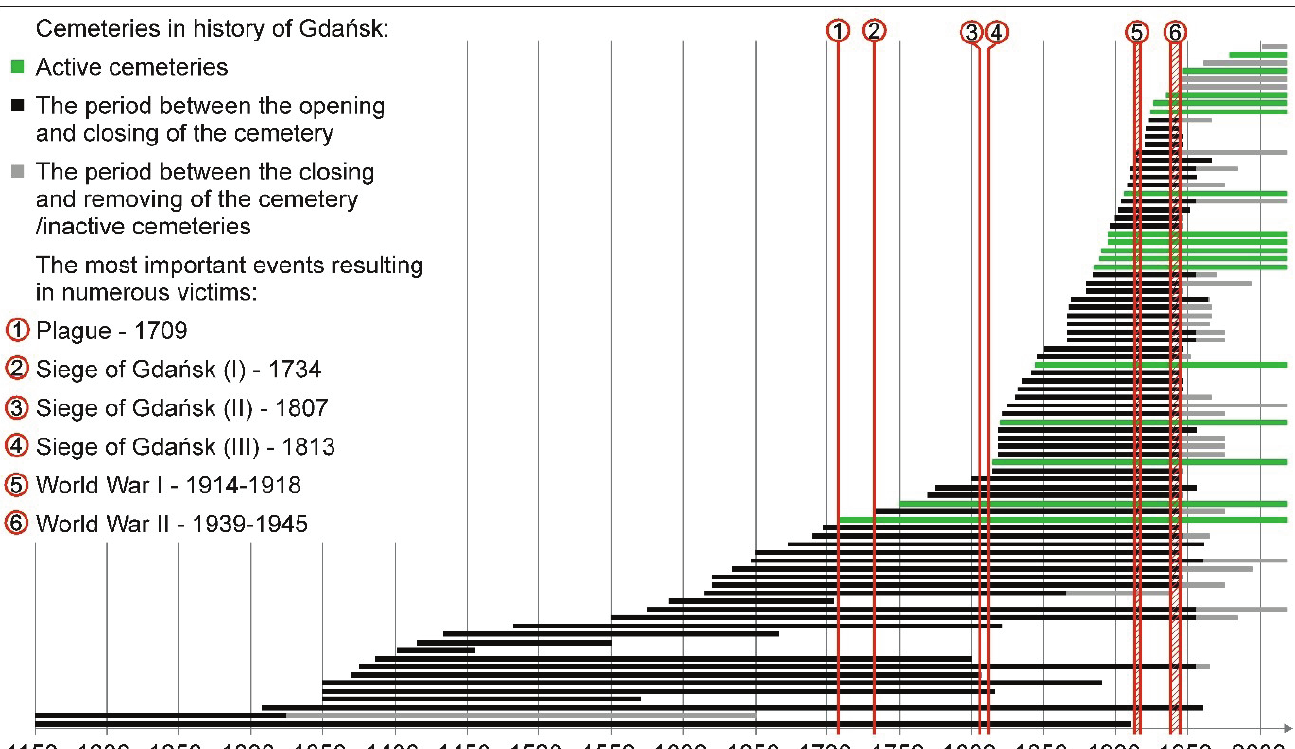
Figure 11. Existence periods of selected cemeteries in Gdańsk. Note: The figure presents only those cemeteries ( Σ =83) for which it was possible to determine dates of their opening and/or closing. For some cemeteries, only an approximate opening/closing period is known. In such cases, a date in the middle of the period was adopted. Source: Own elaboration based on dispersed